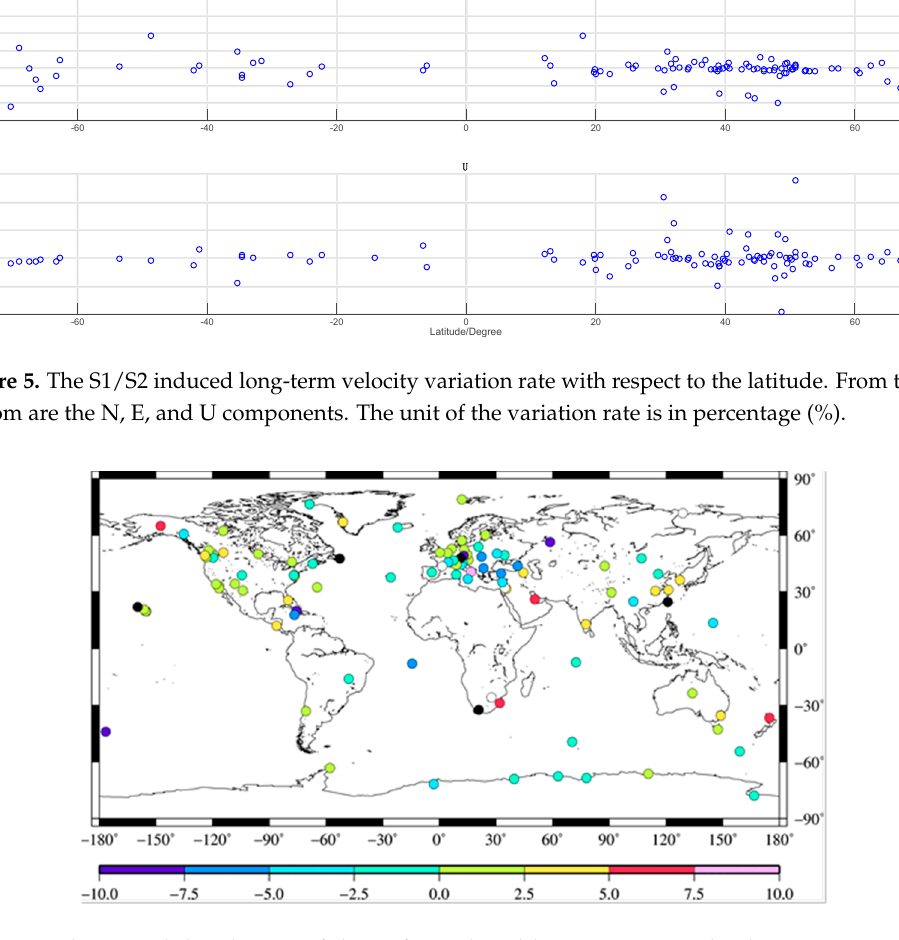
Figure 6. The spatial distribution of the S1/S2 induced long-term vertical velocity variation rate. The unit of the variation rate is in percentage (%). The black and white dots in the figure indicate that the velocity variation rate for the station is smaller than the minimum and larger than the maximum value on the scale.